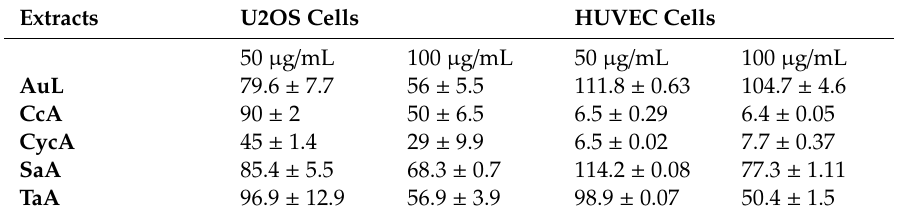
Table 2. Effects of five most active plant extracts on U2OS and HUVEC cell viability. Cells were treated at 50 and 100 µ g / mL concentrations for 24 h. Data are presented as means ± SD of three replicated experiments and represent the percentage of viable cells with respect to the control taken arbitrarily as